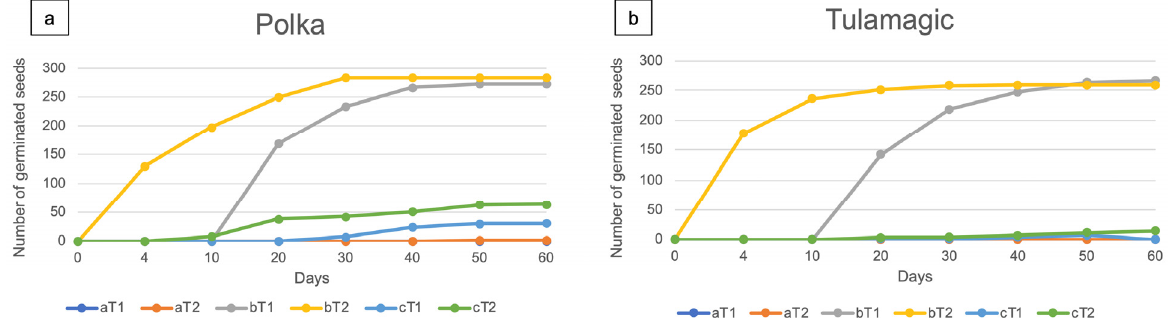
Figure 5. In vitro germination trend of “Polka” seeds ( a ) and of “Tulamagic” seeds ( b ) derived from open pollination, reported as the days required for seeds to germinate after the different treatments. Uncut seed (aT1), transverse cutting (bT1), and seed with longitudinal incision (cT1) stored at 4 °C for 14 days and then placed in growth chamber at 24 °C; uncut seed (aT2), transverse cutting (bT2), and seed with longitudinal incision (cT2) placed directly at 24 °C. The graphs represent the total number of germinated seeds, starting from 125 seeds, of three independent experiments (total number seeds for each condition = 375).